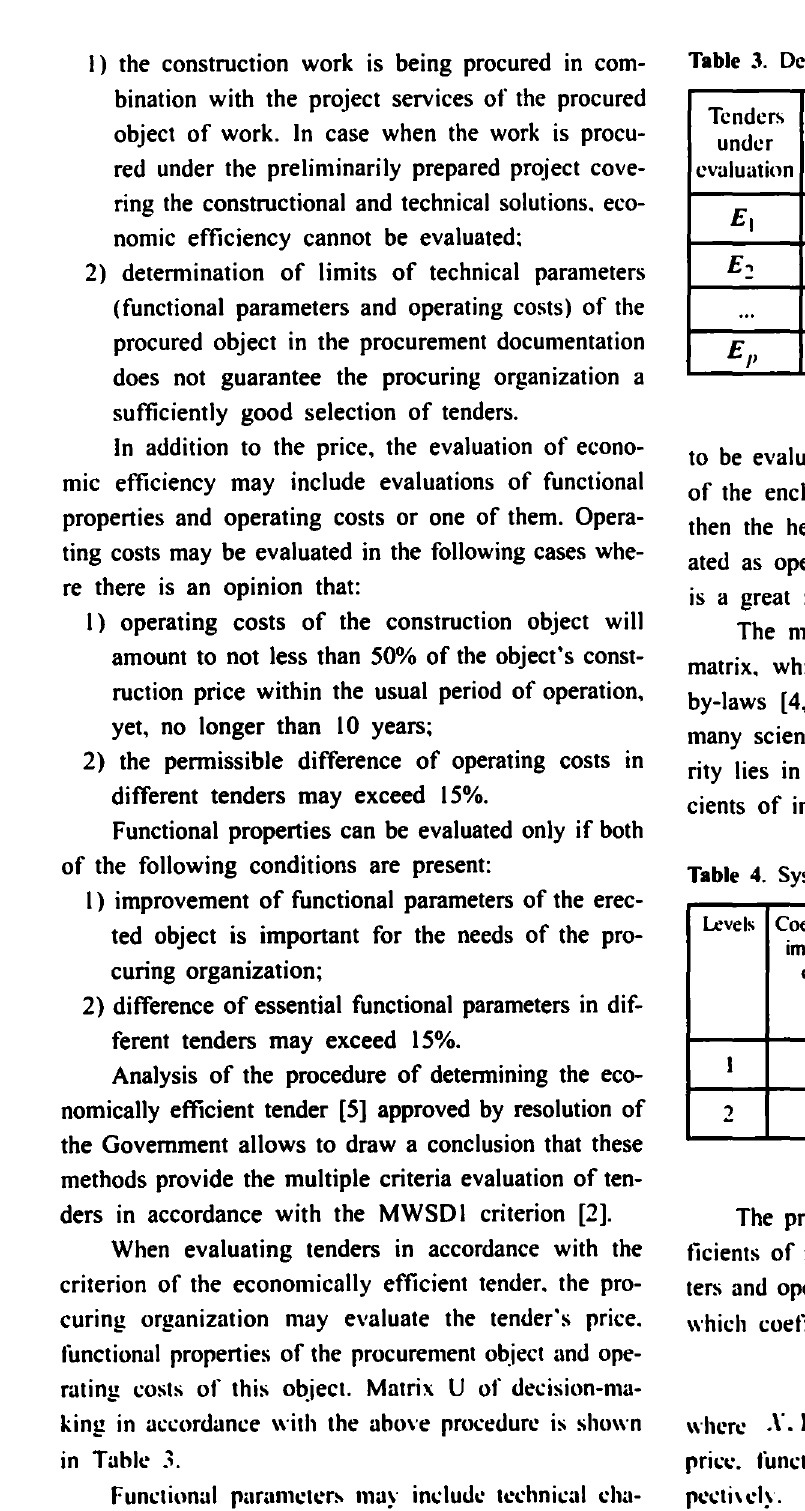
Table 3. Decision-making matrix U Tenders